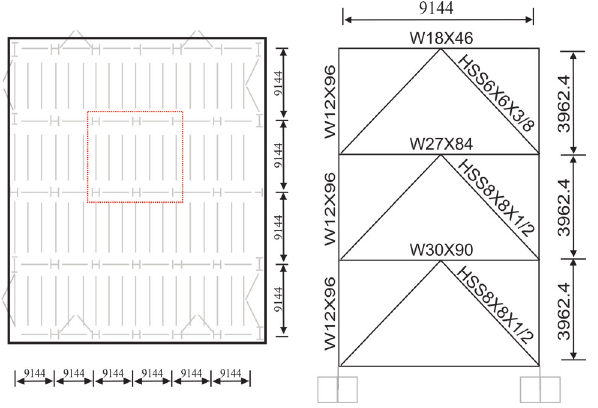
Figure 1: Plan and elevated view of the three-story frames (mm), the penthouse indicated with a dashed line [35].